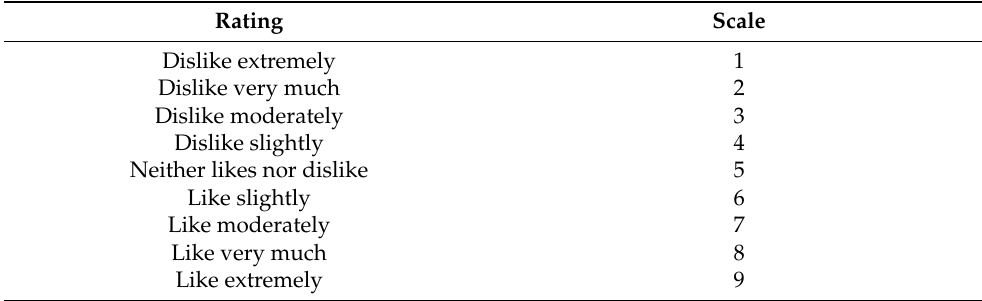
Table 1. Score card for sensory analysis of honey powders fortified with MD, GA and WPC as carrier agents. Rating Scale Dislike extremely